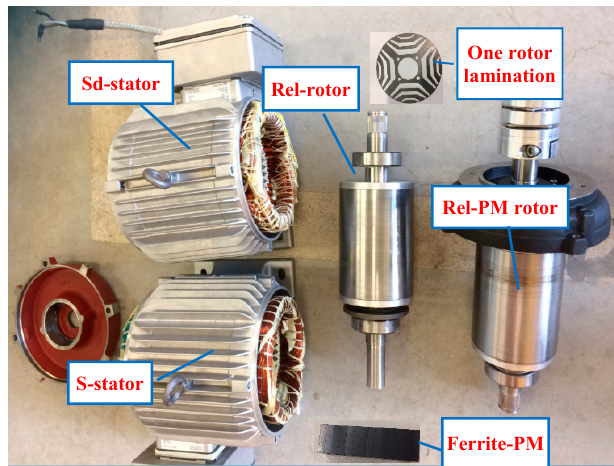
Figure 20. A photograph of the prototypes, where S is a conventional star-connected stator, Sd is a combined star-delta-connected stator, Rel is a conventional rotor without PMs, and Rel-PM is a rotor with PMs.